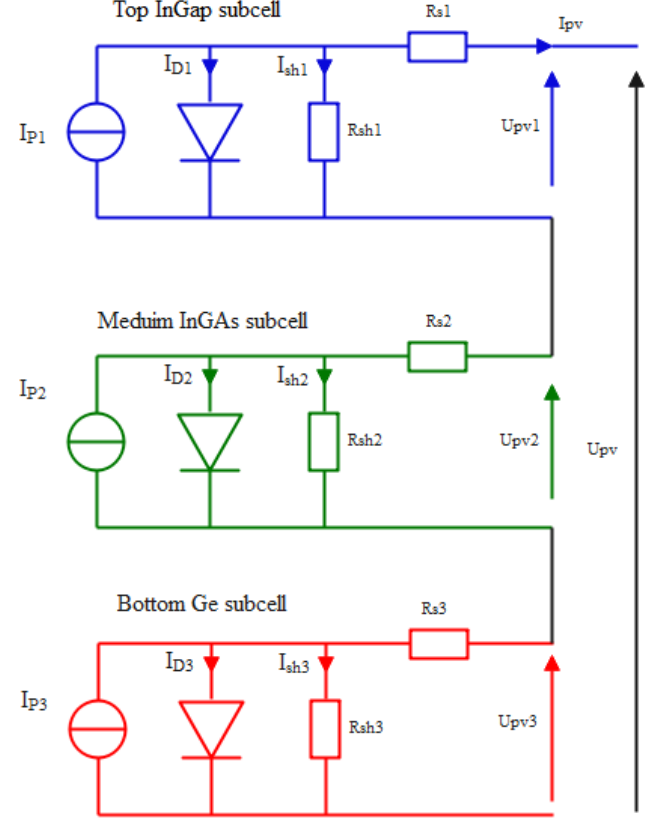
Its voltage equation is given in Equation (4).